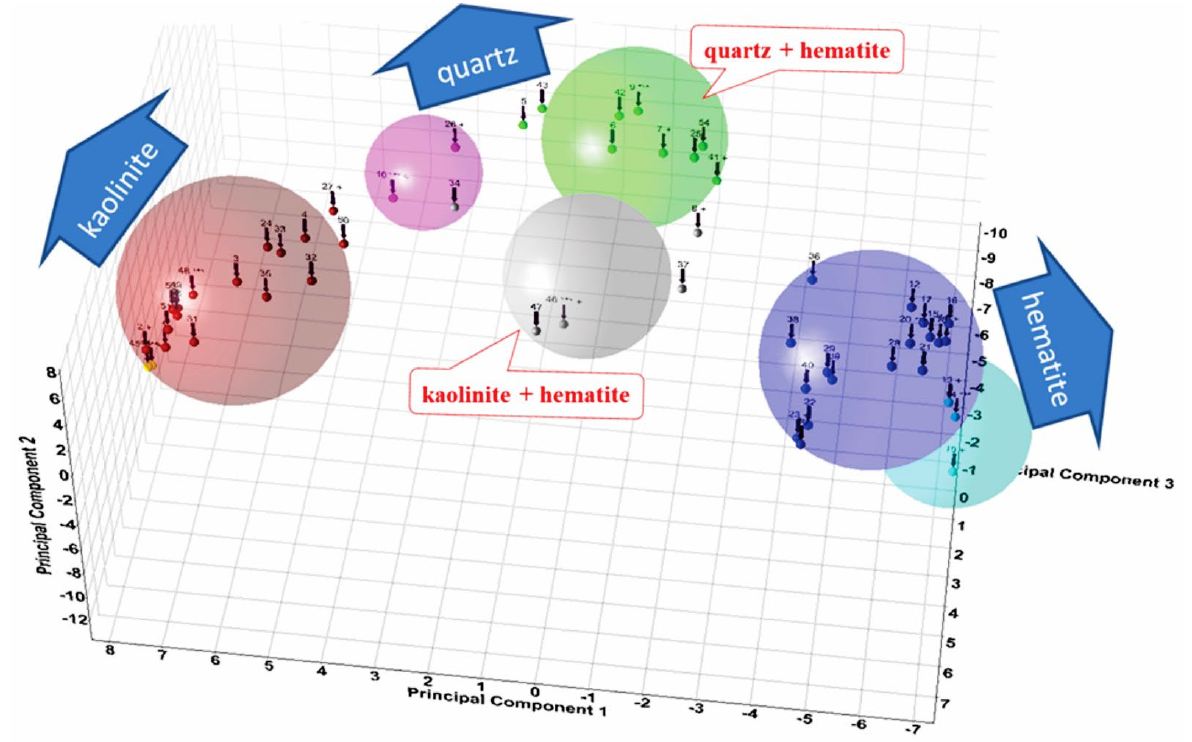
Figure 12. Principal components analysis—PCA for sample mineralogy.